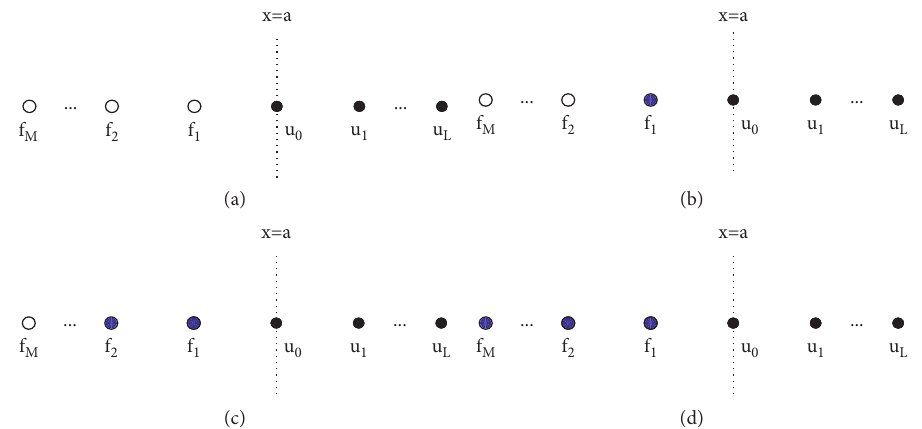
Figure 3: Illustration of determining function values on the fictitious point with the MIB method. (a) M fictitious points and L inner points near the boundary, (b) the first step to determine f f ,f , ... ,f M . 3 4